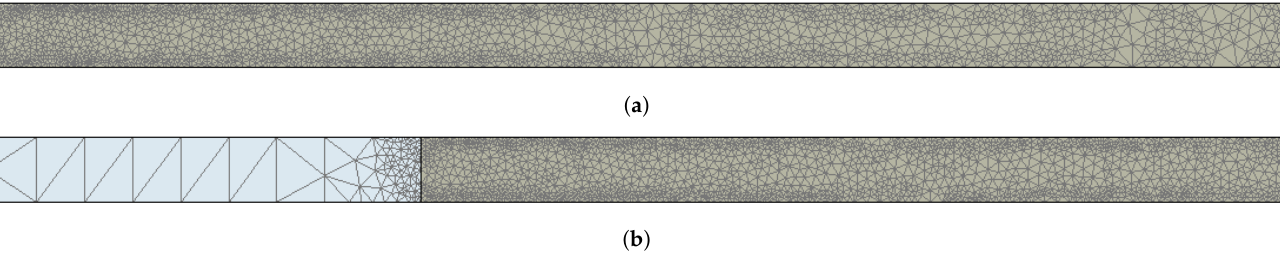
Figure 2. Mesh of the 2D FE axisymmetric model. ( a ) Tank wall without insert, case c = a . ( b ) Tank wall considering an insert, case c − a = 85.0